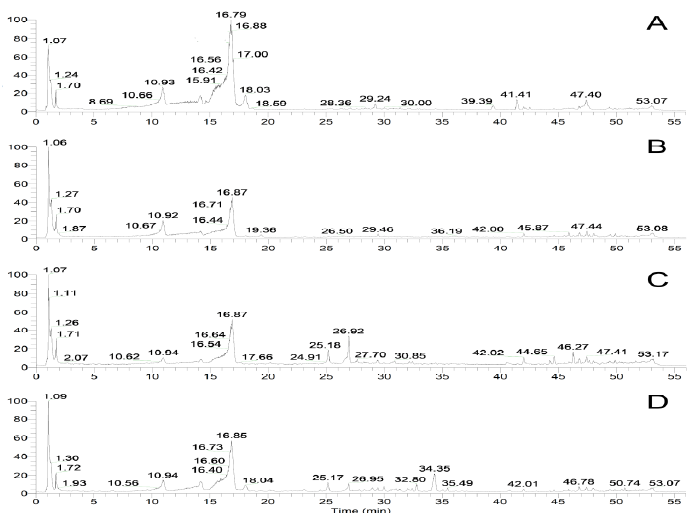
Figure 9. MS TIC chromatograms of roots ( A ), stems ( B ), leaves ( C ), and flowers ( D ) of G macrophylla determined by UPLC-Q-Exactive MS in negative ion mode.